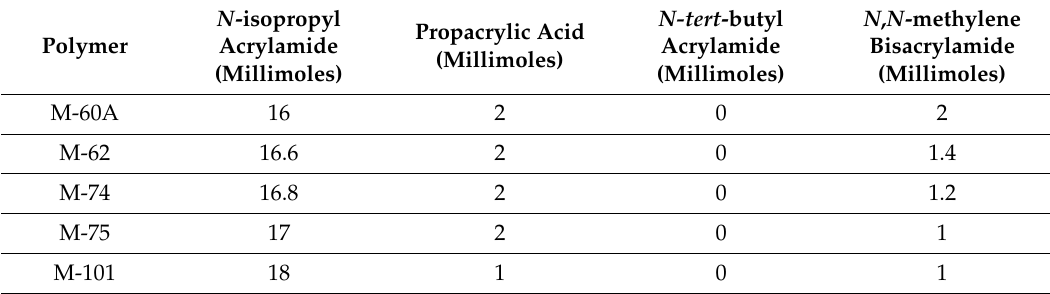
Table 8. pK a Values of N -isopropylacrylamide Copolymers of Propacrylic Acid.